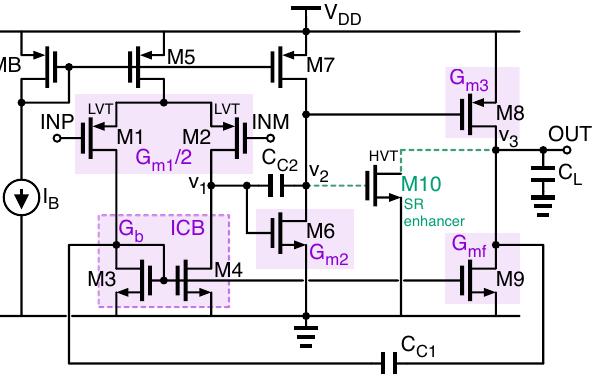
Figure 10. Transistor-level schematic of a three-stage OTA compensated with the Reversed Nested- Miller Compensation with Inverse Current Buffer and Feed-Forward stage (RNMC-ICBFF).